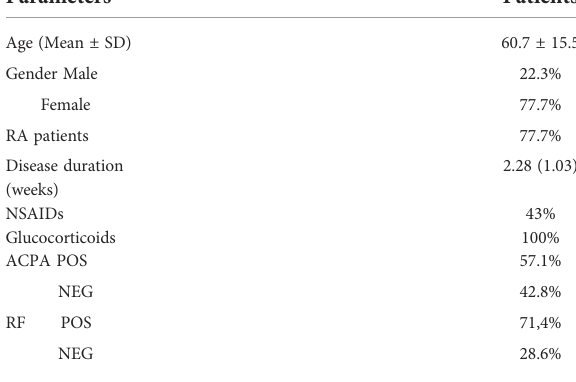
TABLE 1 Characteristics of